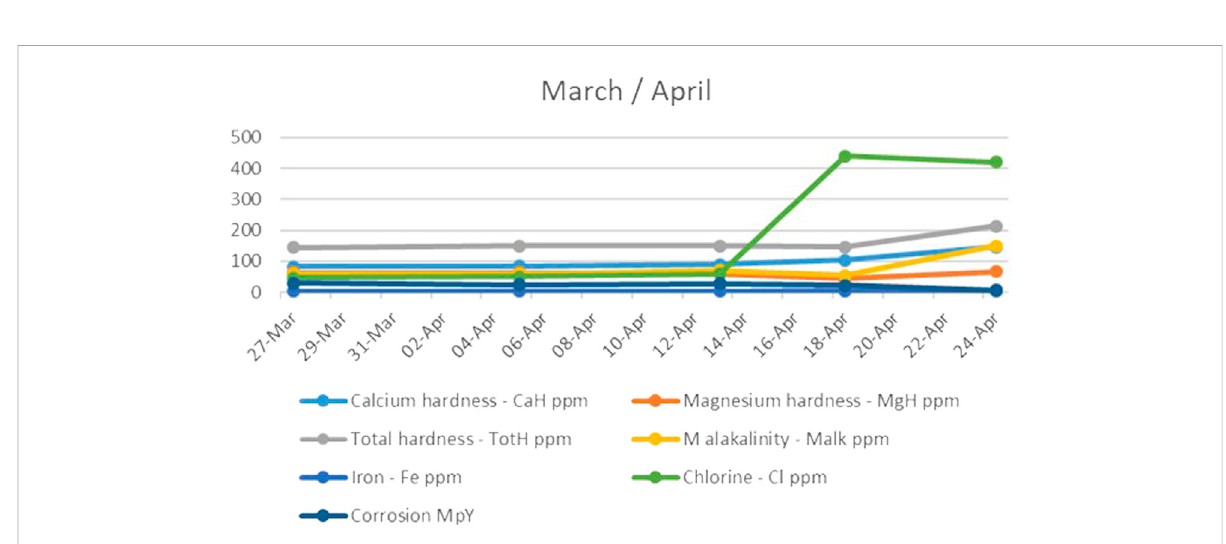
FIGURE 4 The trend of calcium and magnesium hardness, total hardness, M alkalinity, iron, chlorine, and corrosion during the fourth month.